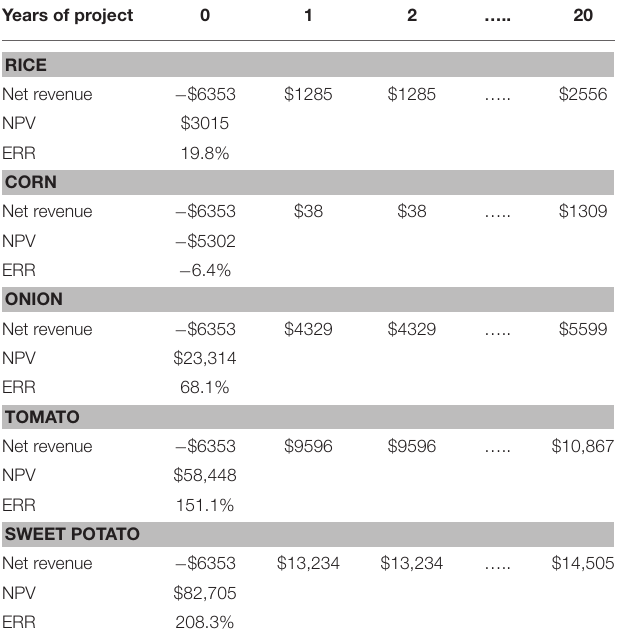
TABLE 2 | Scenario I—The economic NPV and ERR of crops by hectare in the irrigated parcels of S-SRV assuming the CI is equal to 100%, in US dollars.